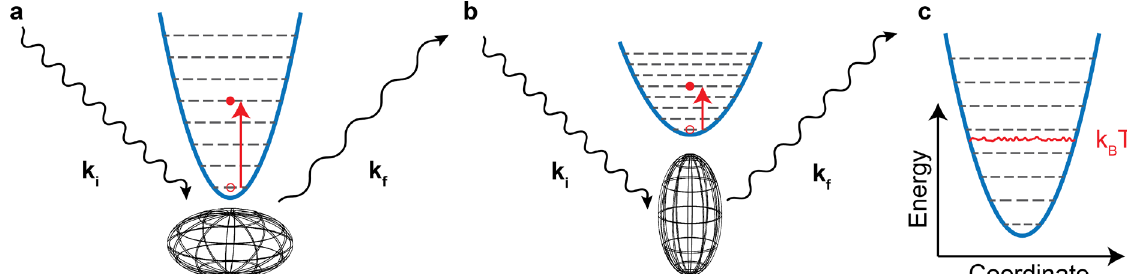
Figure 1. ( a , b ) Schematic depicting neutron scattering off a prolate anisotropic oscillator (oval wireframe object) in two different orientations demonstrating how molecular orientation changes the available scattering processes. In ( a ) the momentum transfer is directed solely along the short axis of the oscillator, creating vibrationally excitations along that axis. In ( b ) the oscillator is rotated such that the momentum transfer is directed along the long axis of the oscillator, which has smaller spacing between energy levels. ( c ) Potential energy surface for a harmonic oscillator. The quantum mechanical levels are represented by grey dashed lines, and the rough red line represents a trajectory of a classical